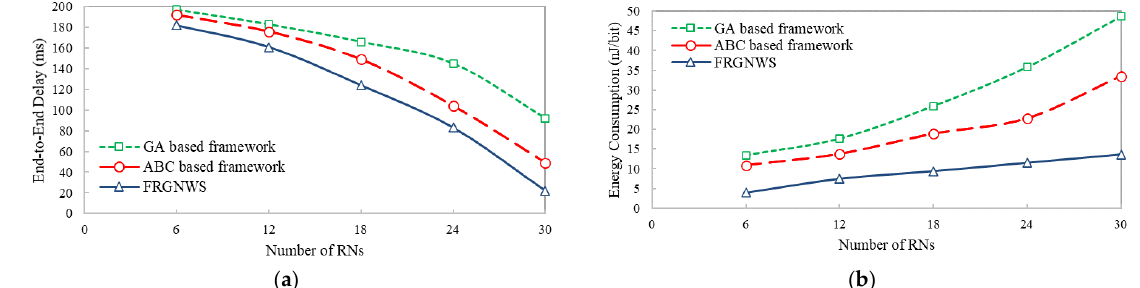
Figure 8. The outcomes of the set of simulation experiments conducted with variations in the number of RNs: ( a ) end-to-end delay with variations in the number of RNs; ( b ) energy consumption with variations in the number of RNs. Tables 13 and 14 are given below. Table 13. The average % effectiveness of the proposed novel framework for the end-to-end delay metric with variations in the number of RNs.